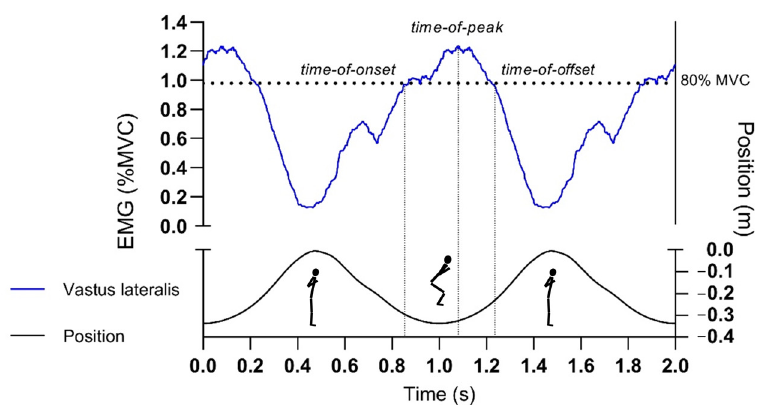
Figure 2. Curves that represent a processed vertical position (bellow) and electromyography (EMG) signal data (above). Time-domain normalized data are presented for two consecutive repetitions at the 0.05 kg · m 2 load. Repetitions were defined from vertical position data cycles starting at the bottom position (approximately 90 ◦ knee angle), then proceeding to the highest position (approximately 0 ◦ knee angle), and again stopping at the bottom position. Time-of-onset, -peak and -offset (dotted vertical lines) were determined from an average of twelve consecutively time-domain averaged repetitions.